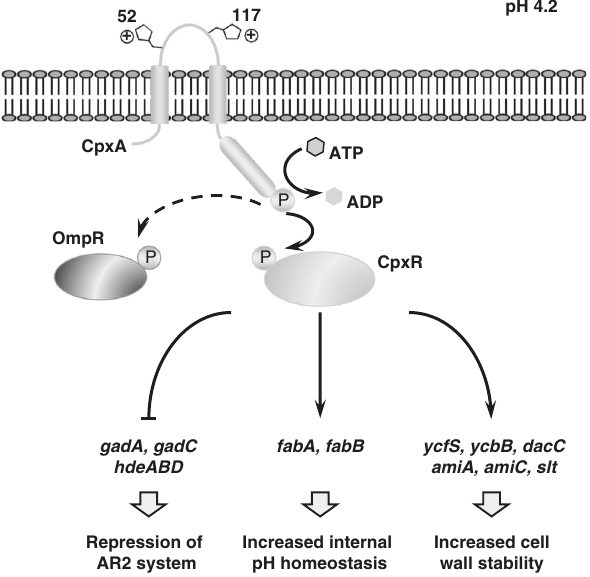
Fig. 7 Model illustrating the CpxRA-dependent gene regulation involved in exponential phase ATR system. In exponentially growing E. coli , CpxRA system is activated by moderate acidic pH through protonation of periplasmic histidine residues, and upregulates the transcription of UFAs biosynthesis genes fabA and fabB , and cell wall modi fi cation genes including ycfS , ycbB , dacC , slt , amiA and amiC , and represses the expression of AR2 system genes. The sensor kinase CpxA also interacts with noncognate response regulator OmpR, which itself plays an important role in E. coli acid